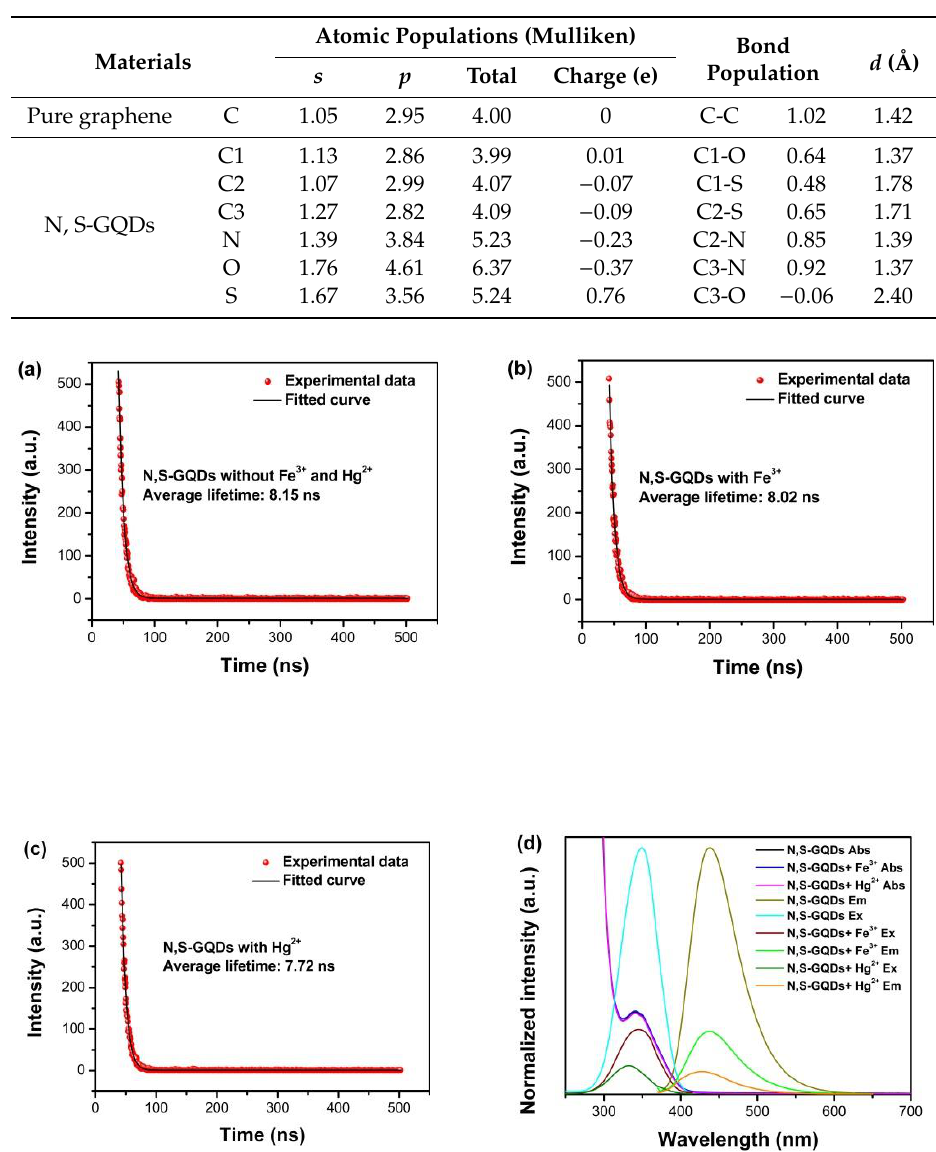
Figure 2. Photoluminescence decay spectra of N, S-GQDs ( a ) without cations and the addition of 10 μM Fe 3+ ( b ) and 10 μM Hg 2+ ( c ), respectively. ( d ) UV-vis absorption spectra (10 μM Fe 3+ and Hg 2+ ) and fluorescence spectra of N, S-GQDs in the presence and absence of 20 μM Fe 3+ and 10 μM Hg 2+ .